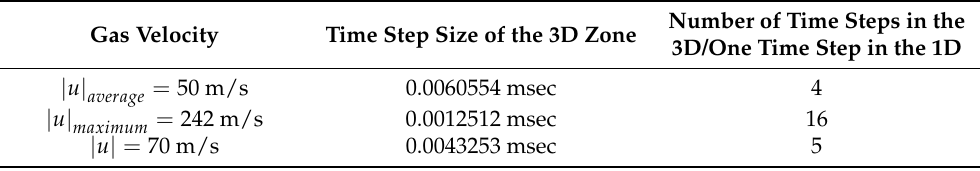
Table 1. Time step size and the number of time steps according to the gas velocity.